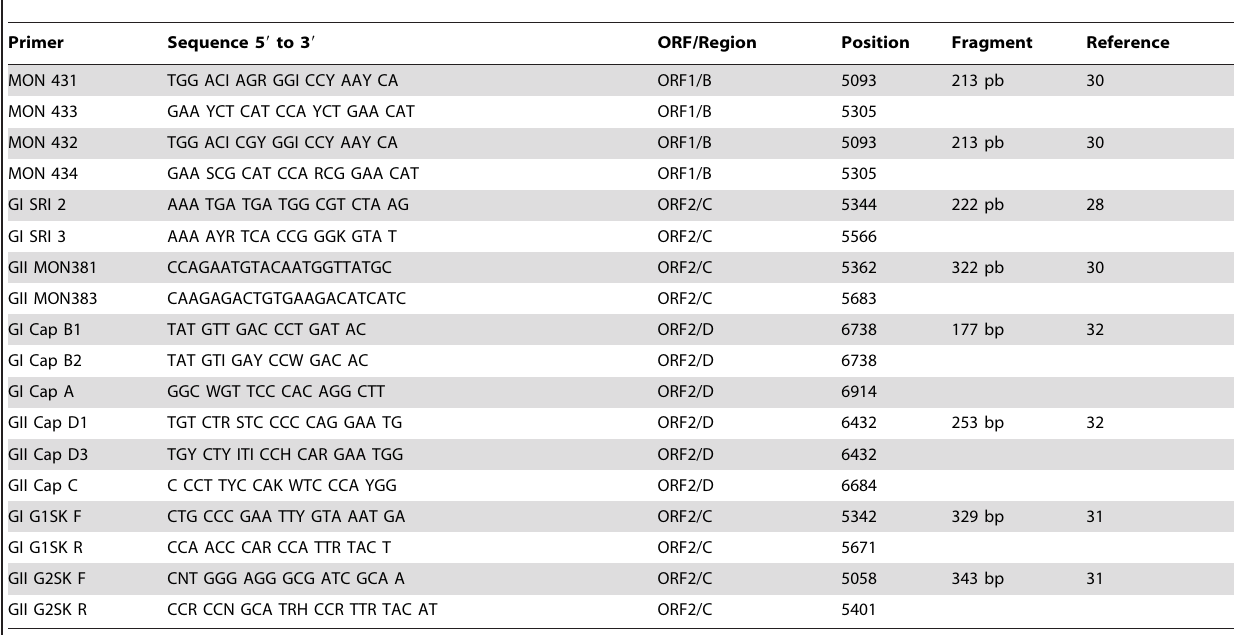
Table 1. Nucleotide sequence of the primers used in amplification and sequencing of the norovirus genome.